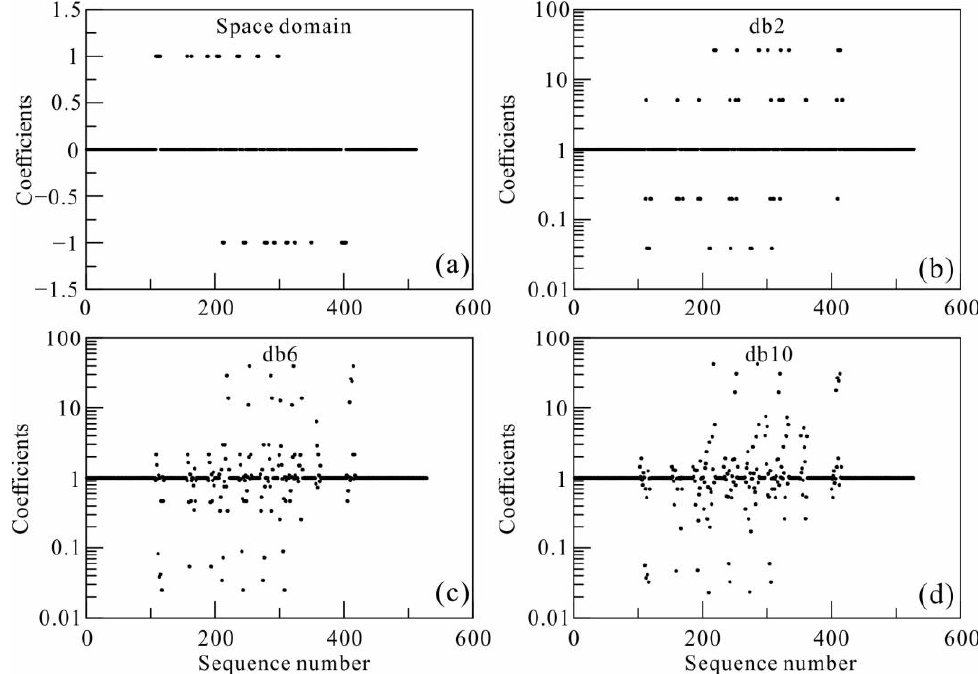
Figure 3. Wavelet coefficients of the forward model in the space domain ( a ) and wavelet domain ( b – d